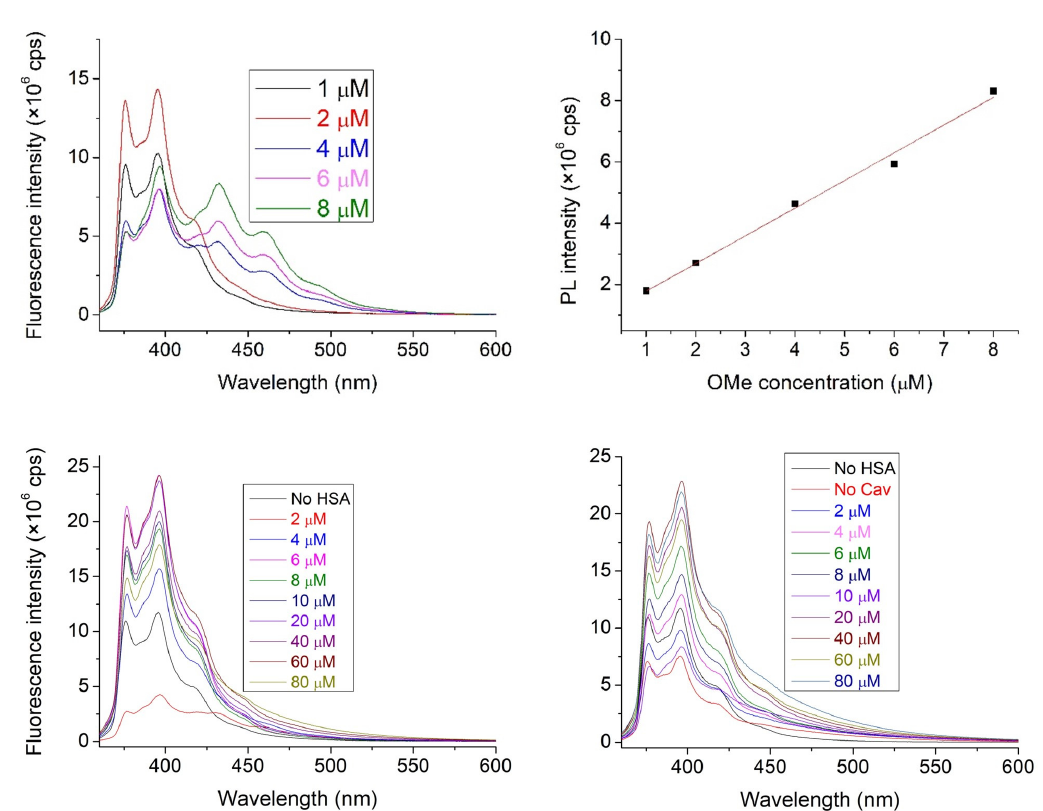
Figure 5. The emission spectra of 6 with an increasing concentration within the 1–100 µ M range ( top left ) and linear correspondence of emission to the fluorophore OMe concentration (adj. R 2 =